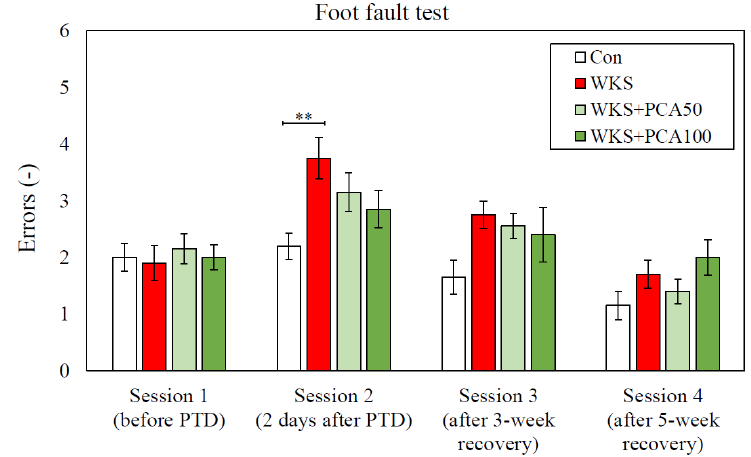
Figure 4. Number of errors (mean ± SEM) per session in Foot Fault test, ** p < 0.01 vs. Con (ANOVA, post-hoc NK).